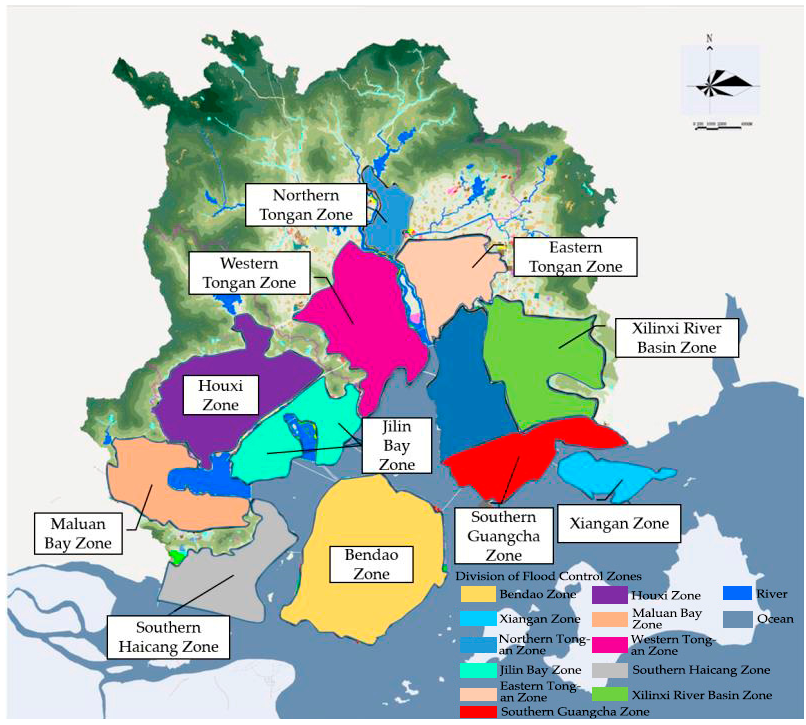
Figure 9. Division of flood control zones in Xiamen.